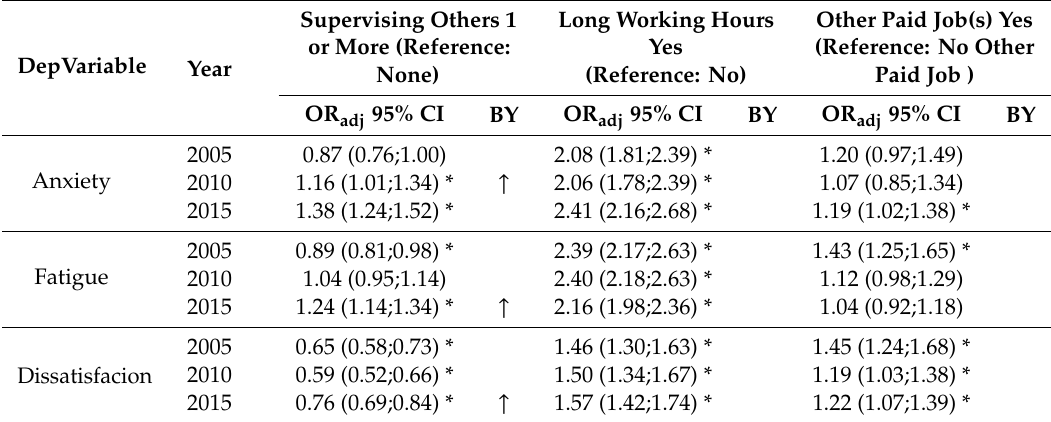
Table 2. Relationship between well-being and supervising others, long working hours and other paid job in